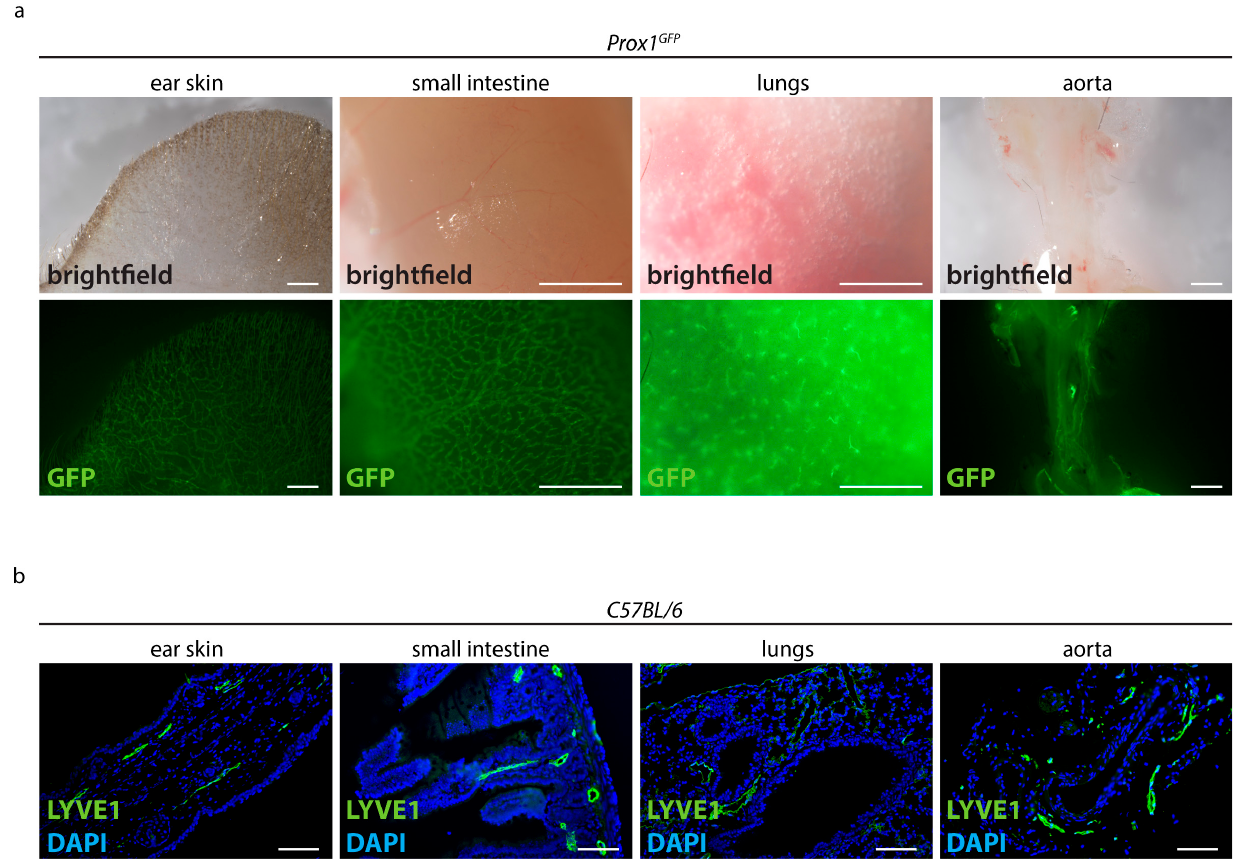
Figure 1. Visualization of the lymphatic vasculature with conventional techniques. ( a ) Detection of the native fluorescence of adult Prox1 GFP lymphatic reporter mice. Brightfield images of various organs and the GFP signals of those samples are shown. Images were acquired by stereo microscopy, scale bar 1000 µ m (n = 10 organs of 10 mice). ( b ) Visualization of lymphatic vessels in paraffin sections of adult C57BL/6 mice stained with the lymphatic marker anti-LYVE1. Pictures were taken with upright microscopy, scale bar 100 µ m (n = 10 organs of 10 mice). Representative images of the experiments are shown.